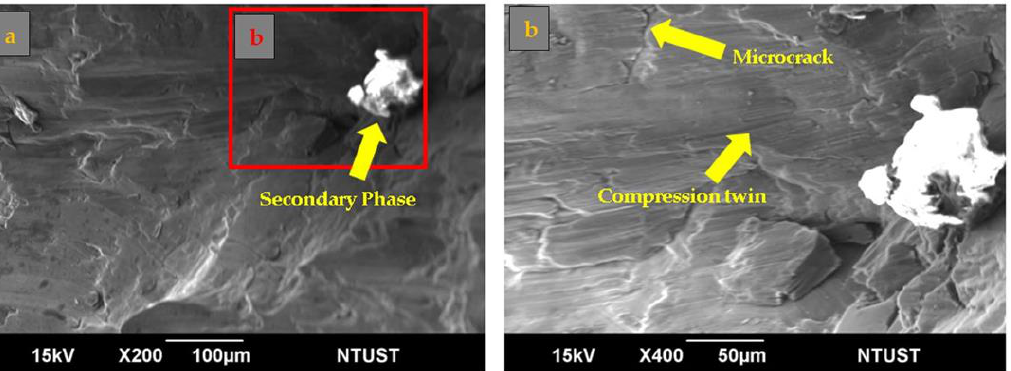
Figure 10. ( a ) The fracture surface morphology of pure AZ31. ( b ) Magnified inset section of figure ( a ).